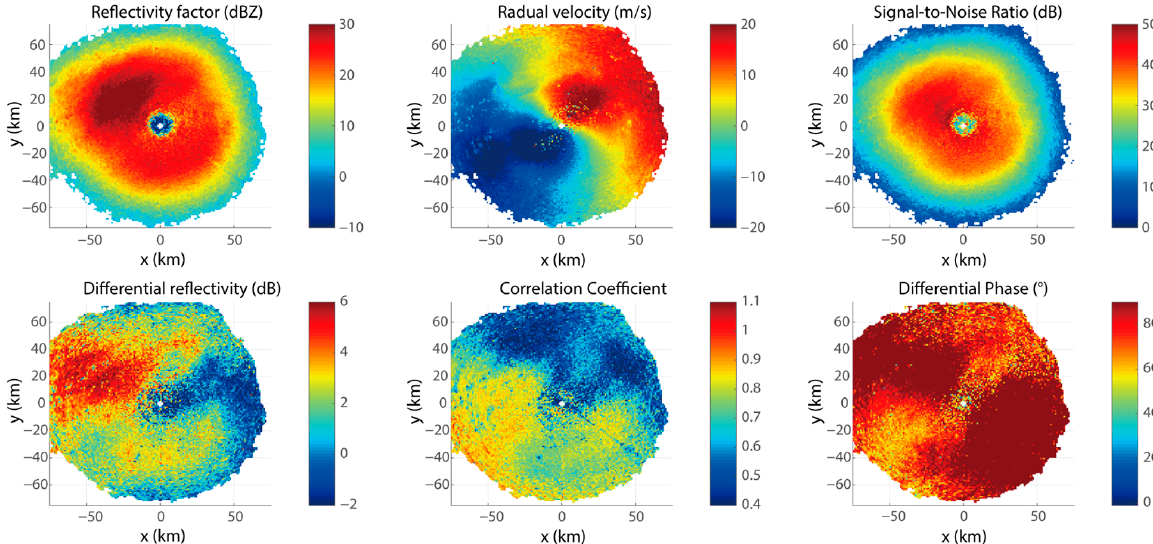
Figure 4. Radar products from the CINRAD/SA radar (SDX), Daxing, Beijing, on 2 May 2021 at 13:00 UTC for an elevation angle of 2.4°. The mapped domain is 75 km by 75 km.